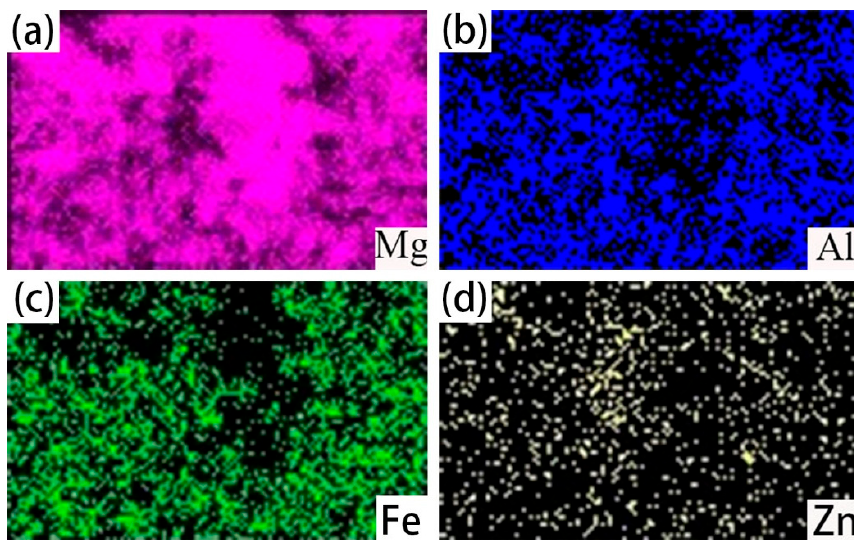
Figure 9. Corresponding EDS maps of the cross-section of the galvanized-steel/AZ91D bimetallic material marked in Figure 7d. ( a ) EDS map scan of Mg element; ( b ) EDS map scan of Al element; ( c ) EDS map scan of Fe element; and ( d ) EDS map scan of Zn element.